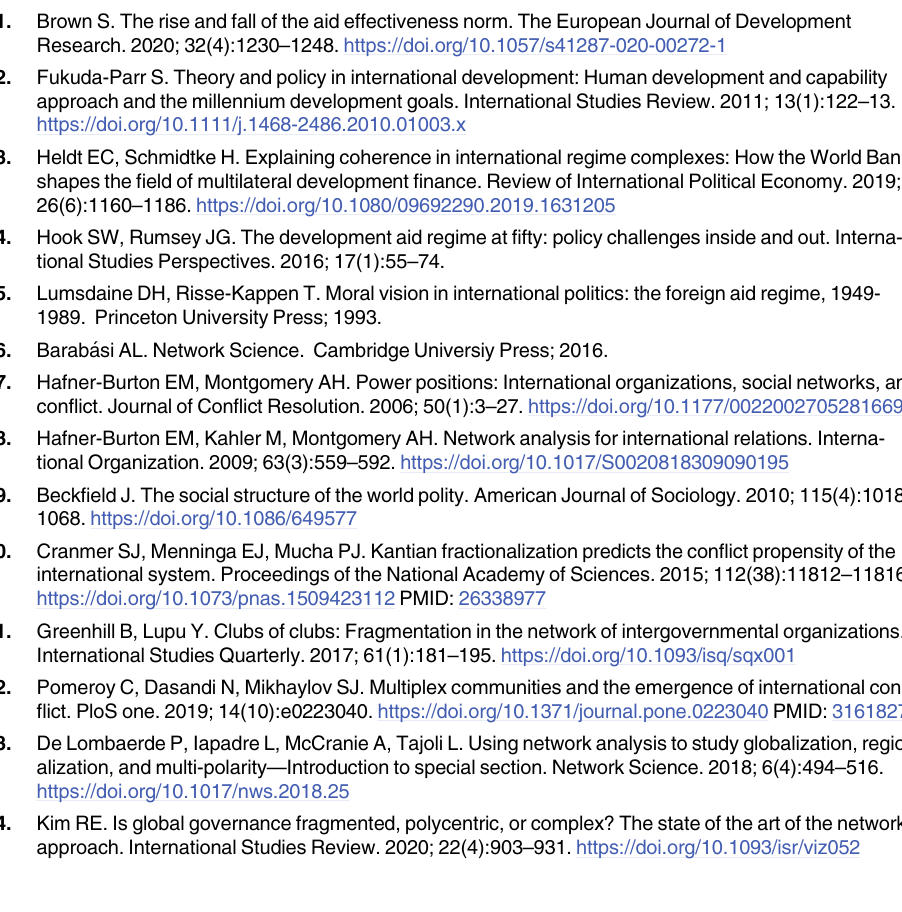
S5 Table. List of actors in the sample block structure in 1990 in Fig 2. S6 Table. List of actors in the sample block structure in 2010 in Fig 2. S7 Table. Top 10 nodes for betweenness